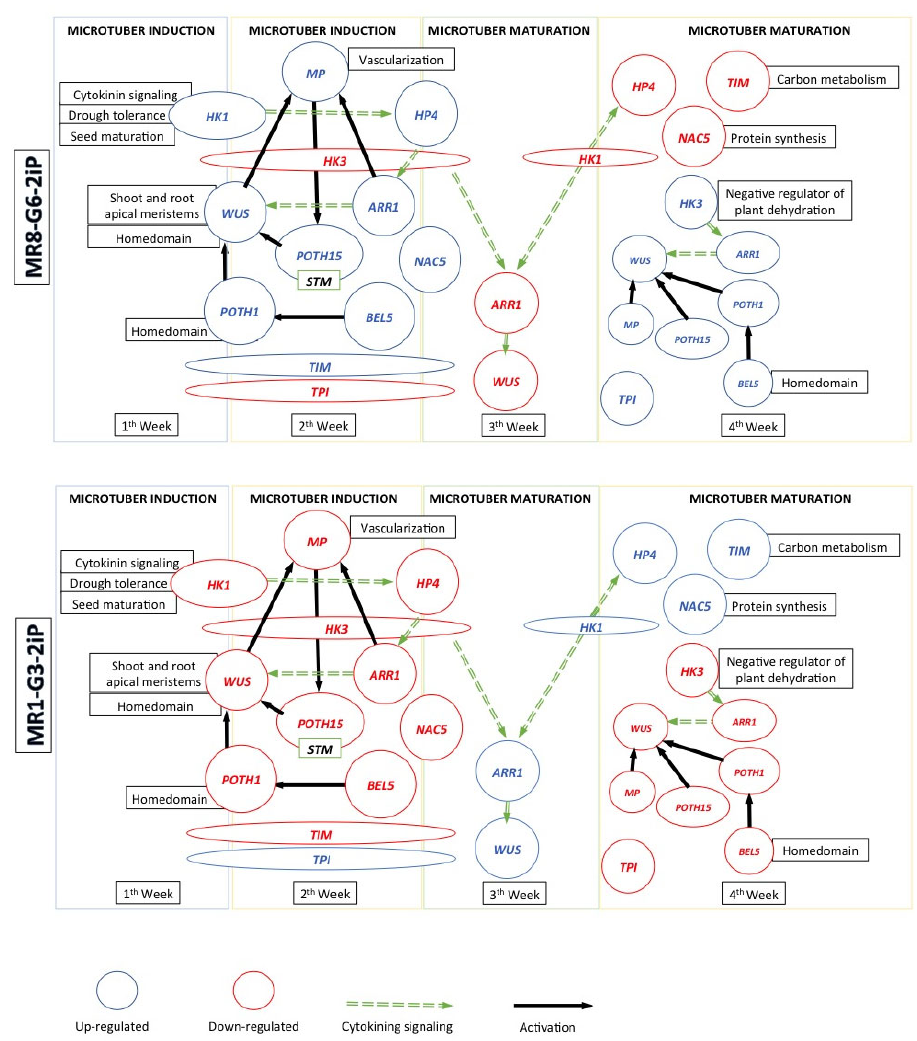
Figure 4. A model of microtuberization regulatory network in two conditions; osmotic stress (MR8 ‐ G6 ‐ 2iP) and non ‐ osmotic stress (MR1 ‐ G3 ‐ 2iP).